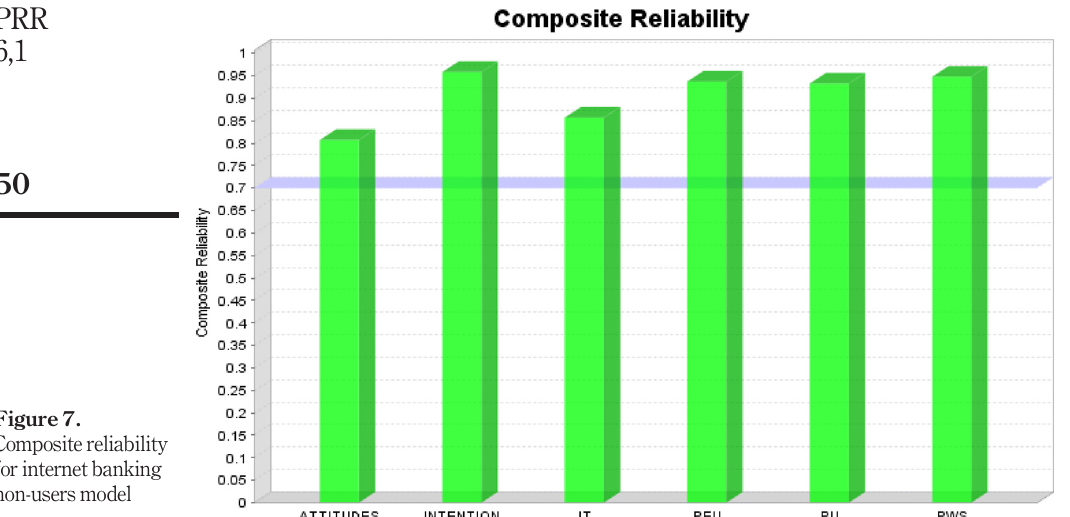
Figure 7. Composite reliability for internet banking non-users model